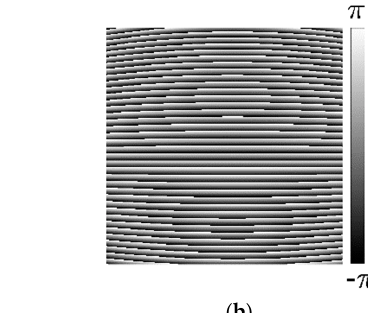
at the 289th row and 273th column, respectively. Figure 5c,d are the corresponding distri- f at the 289th row and bution of f at the 273th column, respectively. The fundamen- x y Figure 4. Wrapped phase. ( a ) Wrapped phase of distorted longitudinal fringe-pattern; ( b ) Figure 4. Wrapped phase. ( a ) Wrapped phase of distorted longitudinal fringe-pattern; ( b ) Wrapped ( , ) x y ϕ and tal frequency is 0.0625 f f = = and the phase ( , ) x y ϕ at the distor- Wrapped phase of a distorted transverse fringe-pattern transverse. 0 0 x xo yo 0 0 y phase of a distorted transverse fringe-pattern transverse. tion center are obtained.